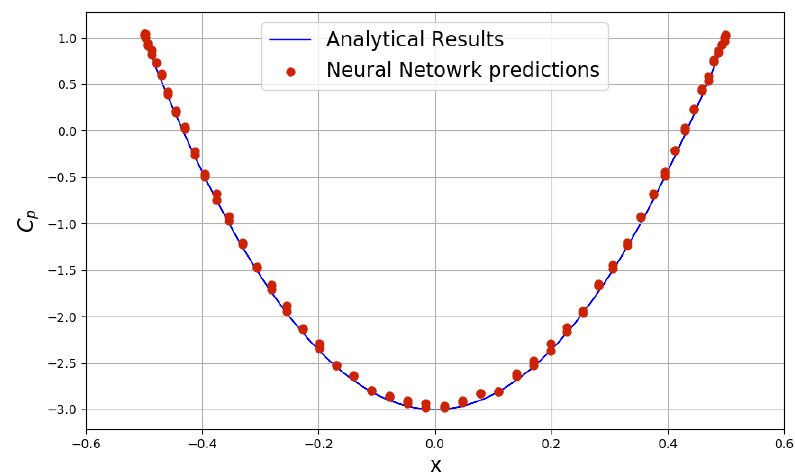
Figure 9. Predicted pressure